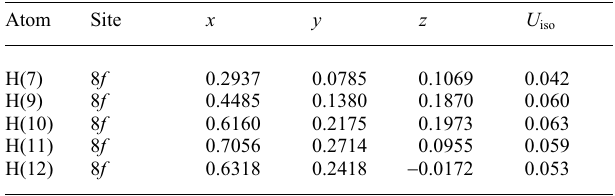
Table 2. Atomic coordinates and displacement parameters (in Å 2 )